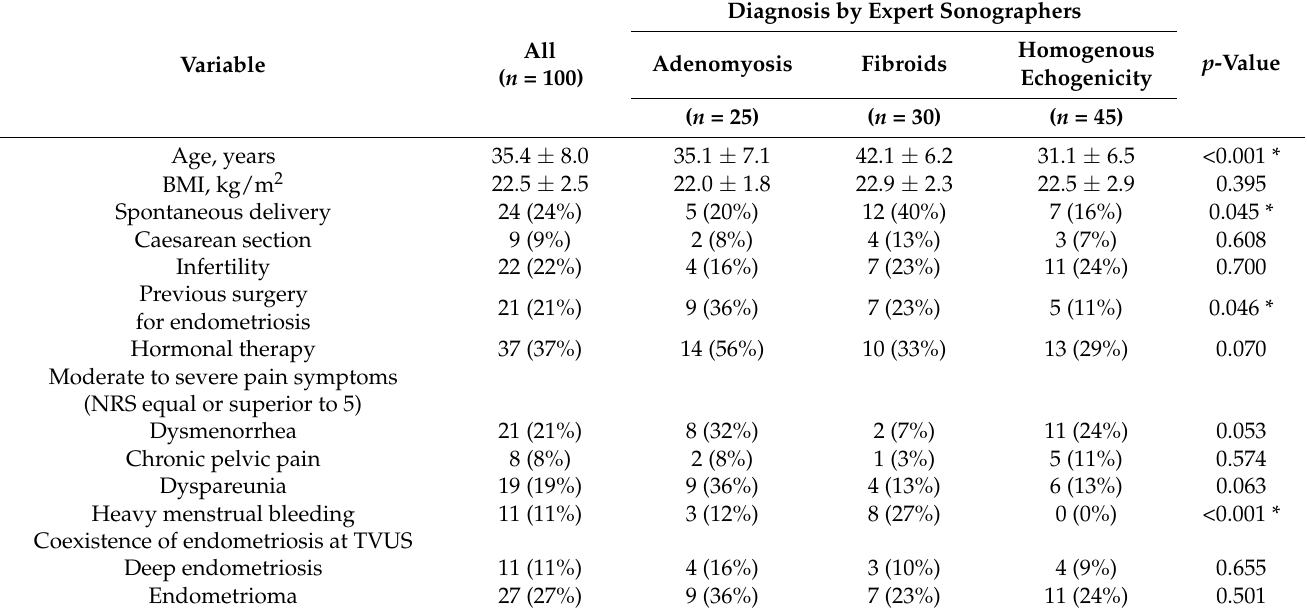
Table 1. Baseline characteristics of the study sample and of the three types of diagnosis by expert sonographers.